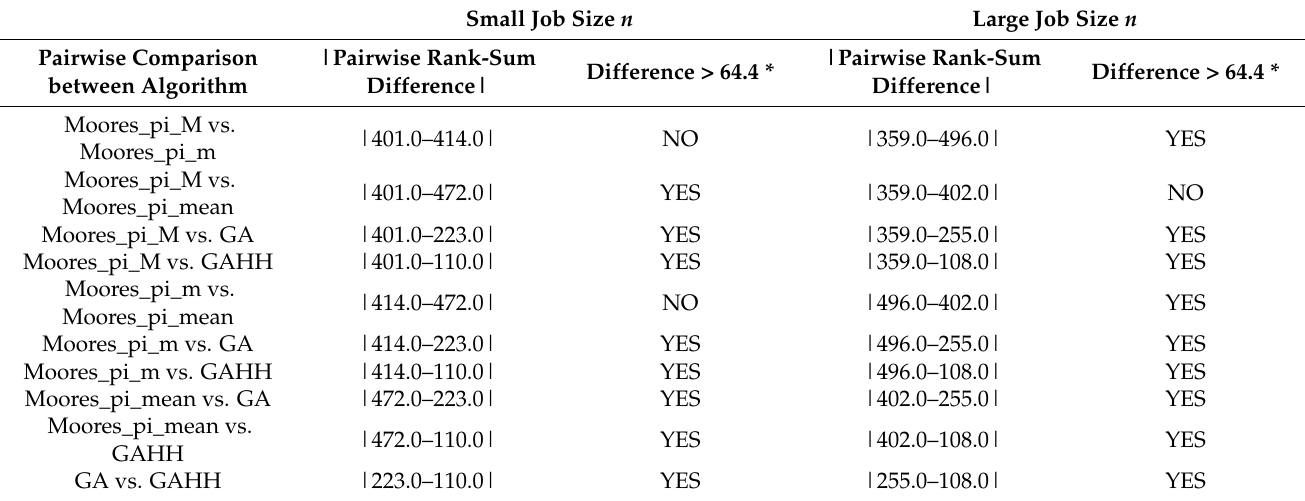
Table 3. Nonparametric multiple comparisons of AEP and relative percentage deviation. Small Job Size n